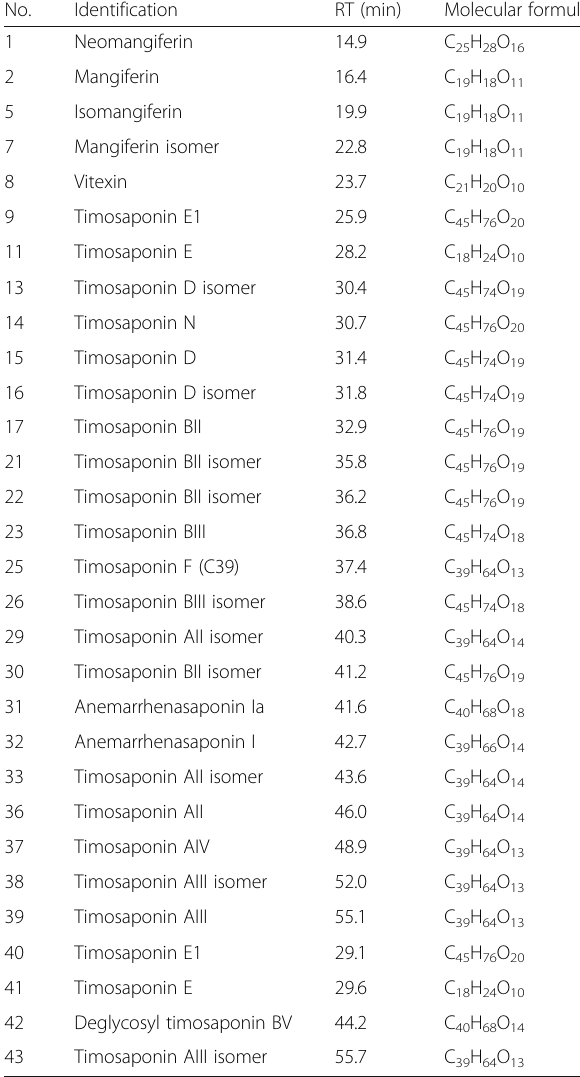
Table 3 The components of Anemarrhena asphodeloides identified by HPLC-MS/MS